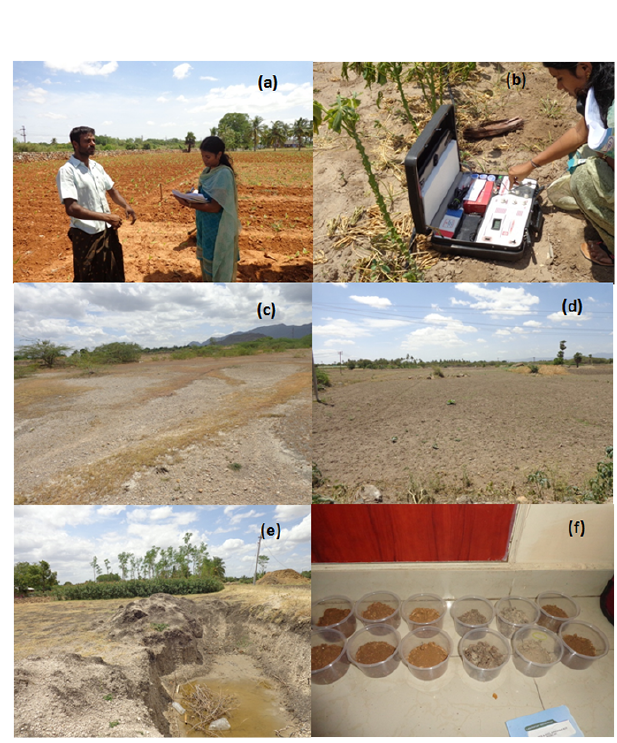
Figure 5. (a) Questionnaire with a local farmer. (b) Direct in situ measurement to evaluate the chemical properties of the soil. (c) Highly saline-affected region. (d) Soil moisture stress zone. (e) Land reclamation process hampered by the presence of hard pans. (f) Soil samples collected for testing the chemical